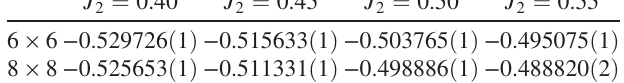
TABLE I. Raw data of RBM þ PP ground-state energy in Fig. 10. J 0 . 40 2 ¼